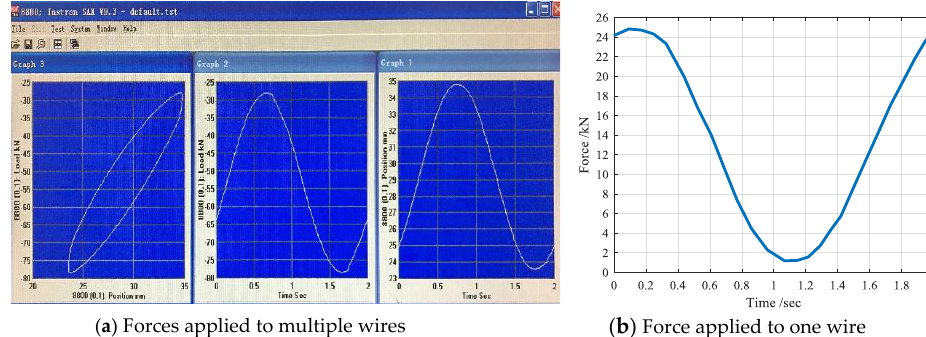
Figure 9. Process and work principle of data collection by LabVIEW.